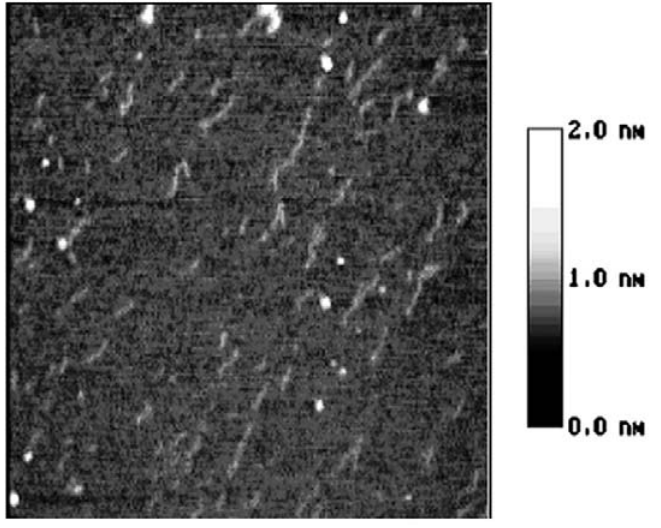
Figure 7. The AFM image of starch nanochains when heated in 100 °C water bath for 40 min, size 2.0 × 2.0